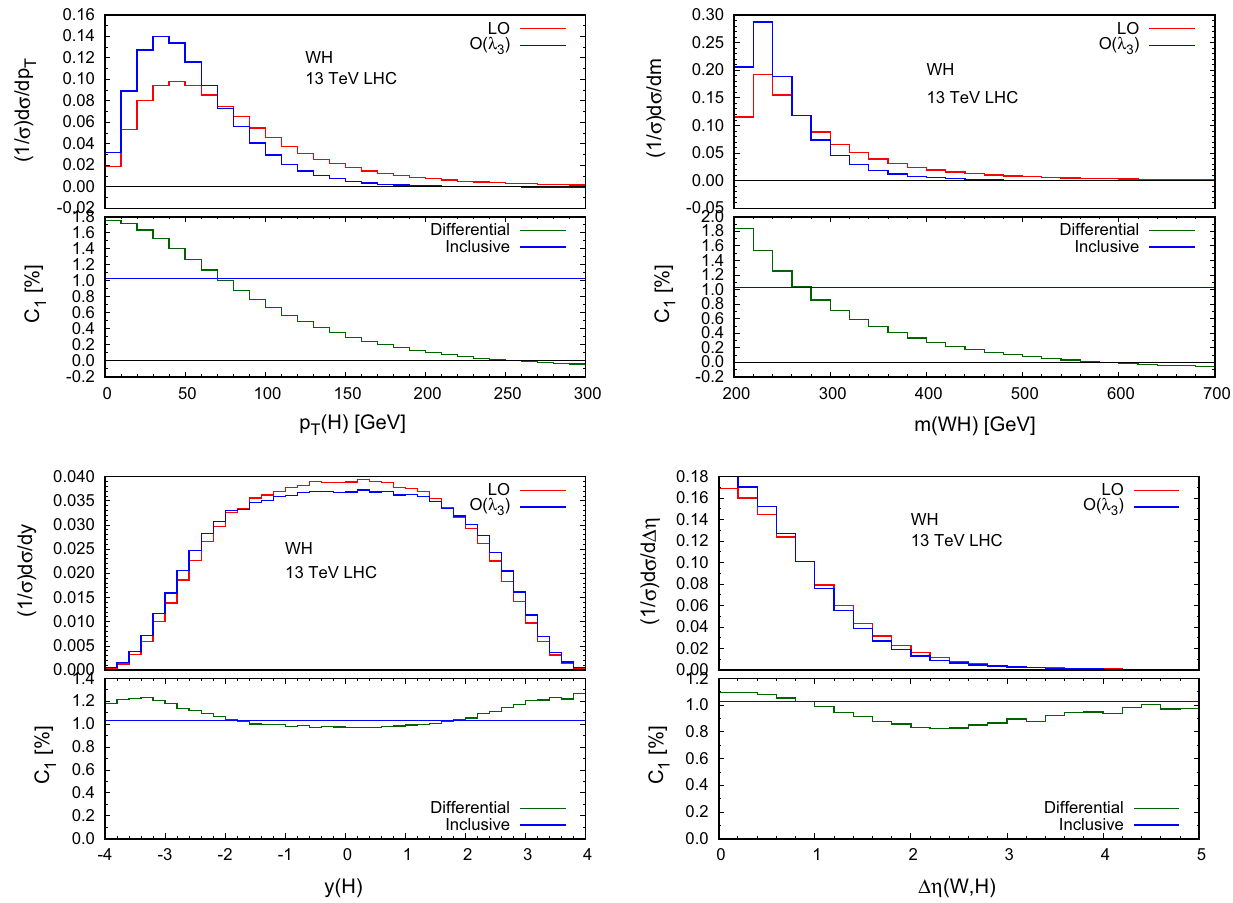
Fig. 4 Effect of O (λ 3 ) correction in W H at 13 TeV LHC. Upper panel: normalized distributions at LO (red) and at O (λ 3 ) (blue). Lower panel: C 1 at the differential (green) and inclusive (blue)